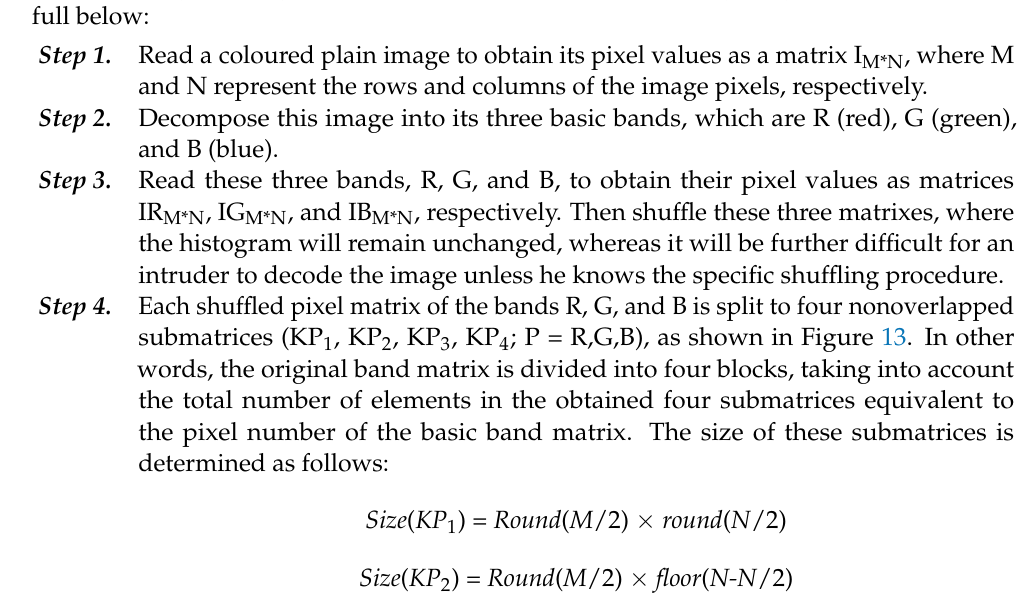
Figure 13. Block illustration of the image encryption algorithm using the fractional-order memcapacitive hyper chaotic model (17).